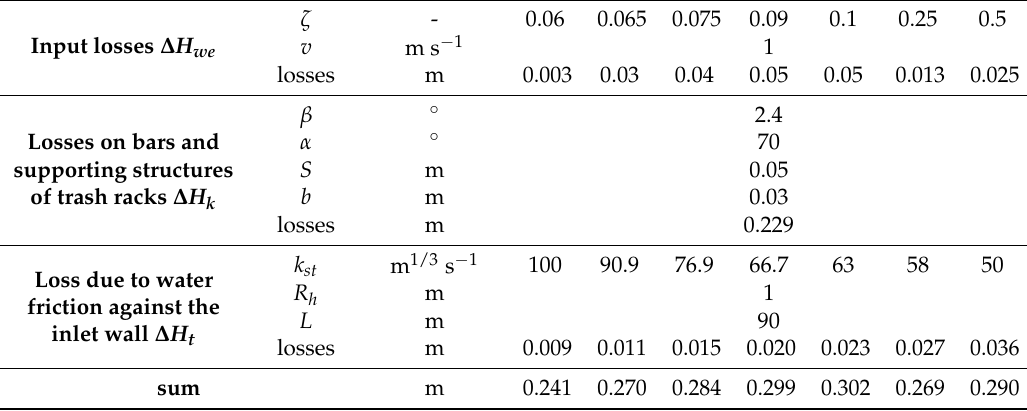
Table 6. Hydraulic losses for shape coefficient β = 2.4.